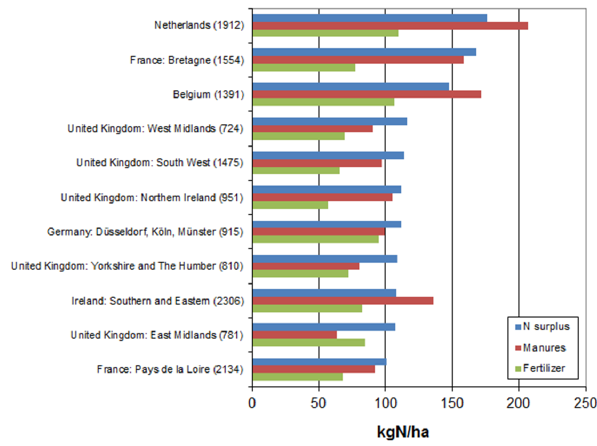
Fig. 2. Annual soil N balance (soil N surplus) and N inputs from Figure 2. Annual soil N balance (soil N surplus) and N inputs from manure and fertilizer in 2 manure and fertilizer in 2008 by MITERRA for regions in north- 2008 by MITERRA for regions in northwestern Europe of comparable UAA and N surplus 3 western Europe of comparable UAA and N surplus exceeding exceeding 100 kgN/ha (NUTS1 level or clusters of NUTS2; UAA in 1000 ha in between 4 100kgNha − 1 (NUTS1 level or clusters of NUTS2; UAA in 1000 brackets). 5 ha in between